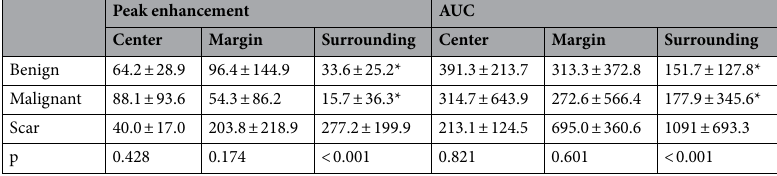
Table 1. Numeric values for perfusion analysis for Peak Enhancement and AUC for the Regions of Interest (ROI) in the center, at the margin and the surrounding tissue for benign and malignant lesions as well as for scars. *p < 0.05 versus scar.